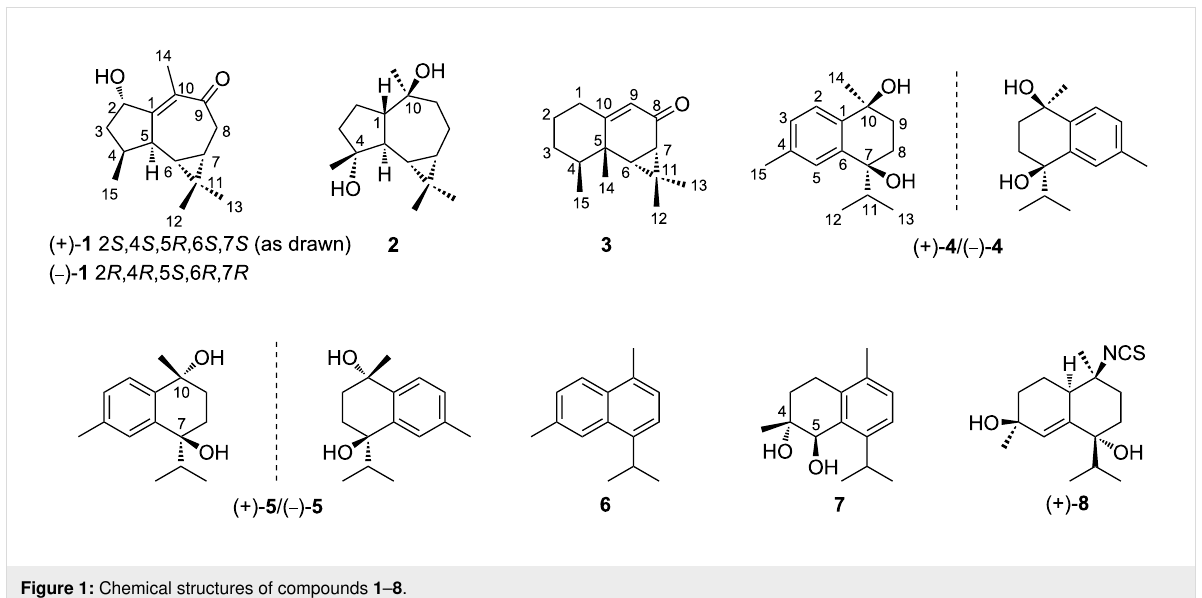
Figure 1: Chemical structures of compounds 1 – 8